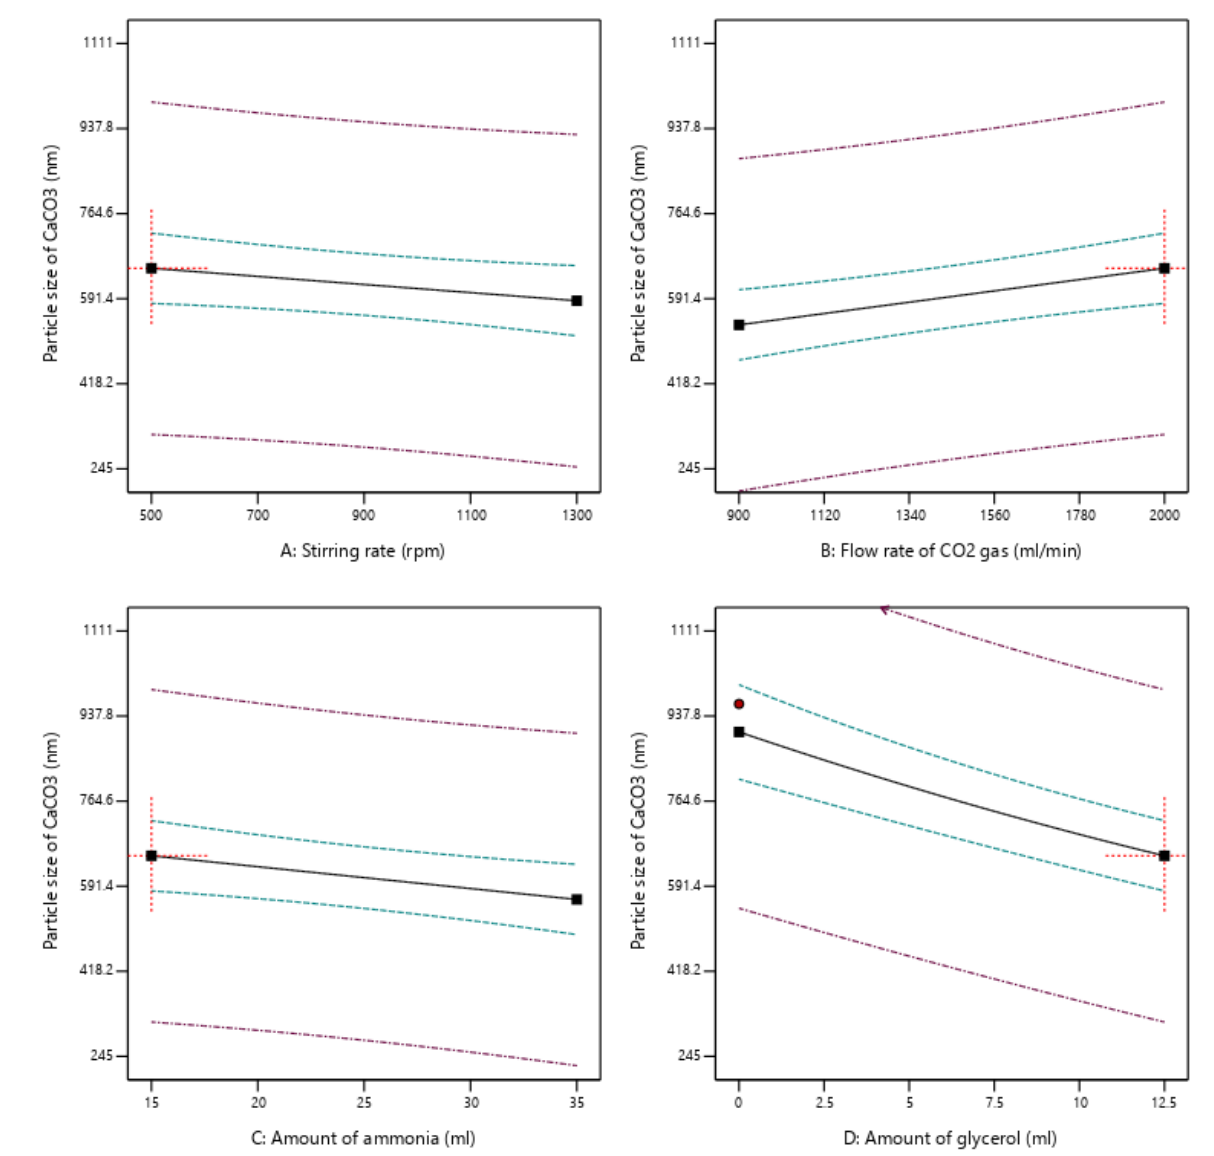
Figure 12. Process variables affect the CaCO 3 particle size .